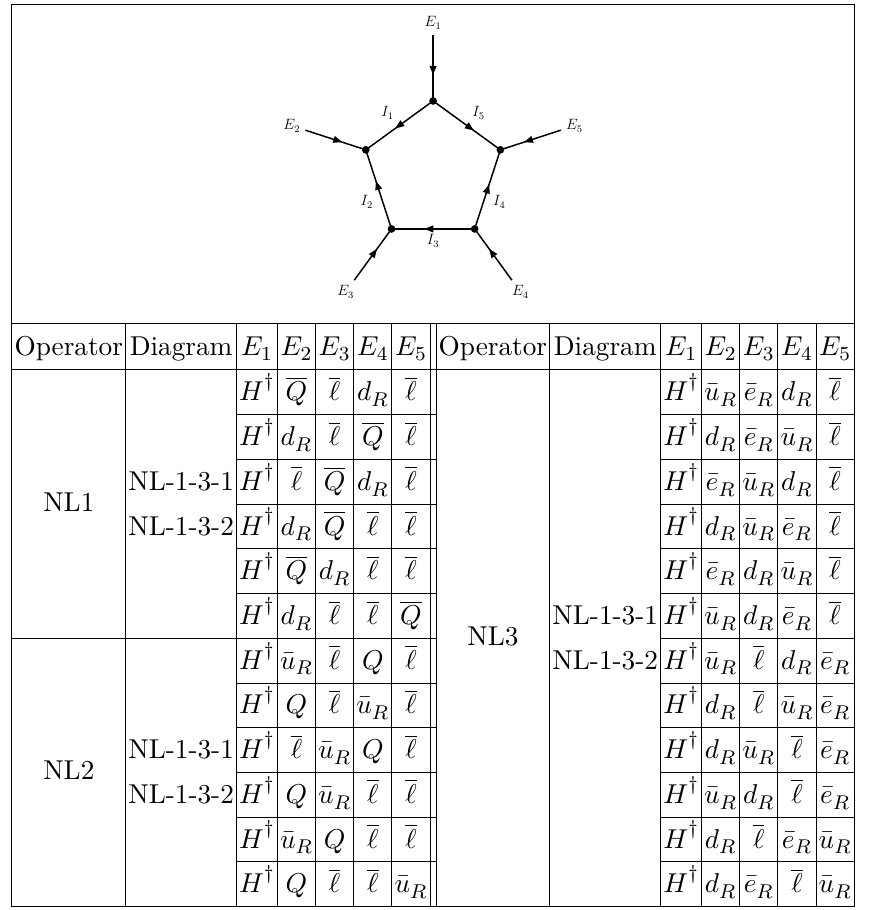
Table 4 . The possible external field attachments for the topology NL-1-3, where the external and internal fields are labelled as E